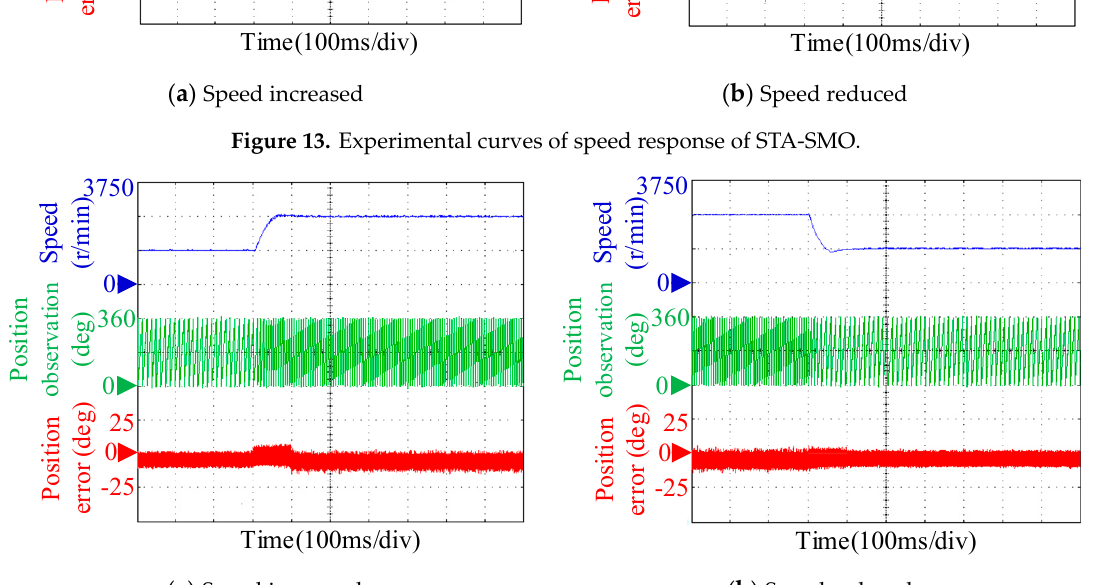
Figure 14. Experimental curves of speed response of STA-SMO with APEC.